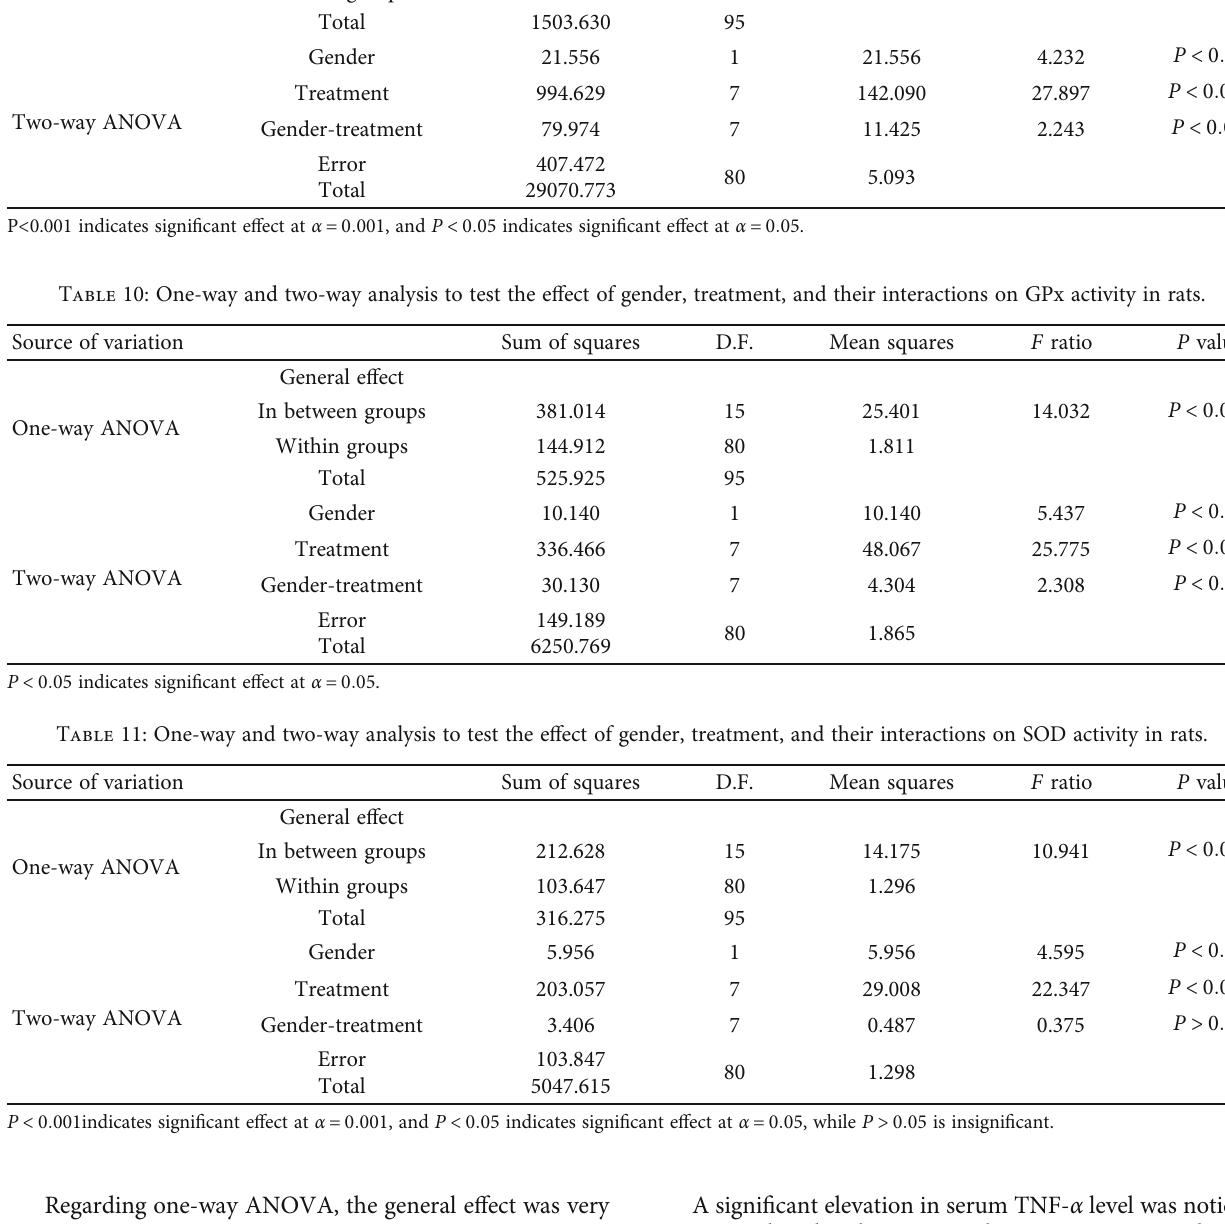
Table 9: One-way and two-way analysis to test the e ff ect of gender, treatment, and their interactions on GST content in rats. Source of variation Sum of squares